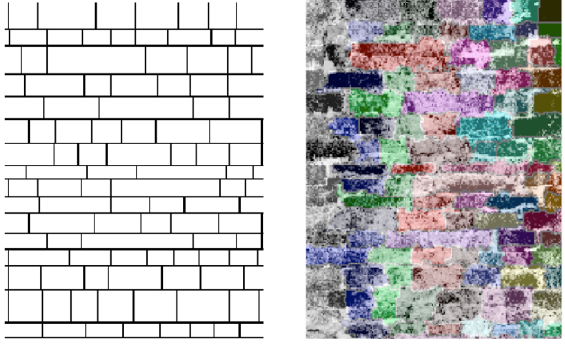
Figure 4. Results of the segmentation process; contours for markings to be used in the marker-controlled watershed segmentation (left) and results of watershed segmentation superimposed to the intensity image of the wall (right).